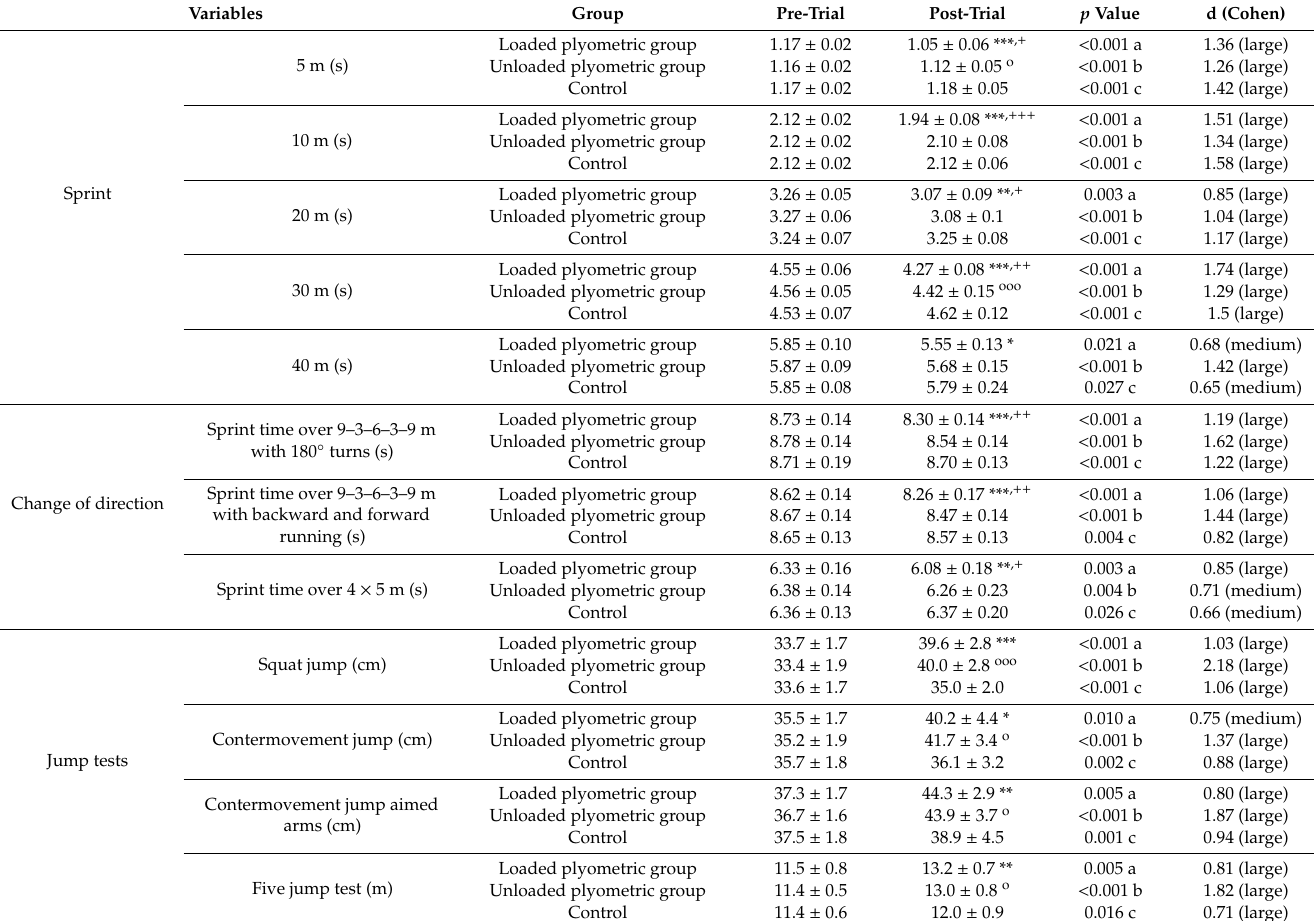
Table 4. Inter-group comparison of sprint running, change of direction and jump performances before (pre) and after (post) the 10-week